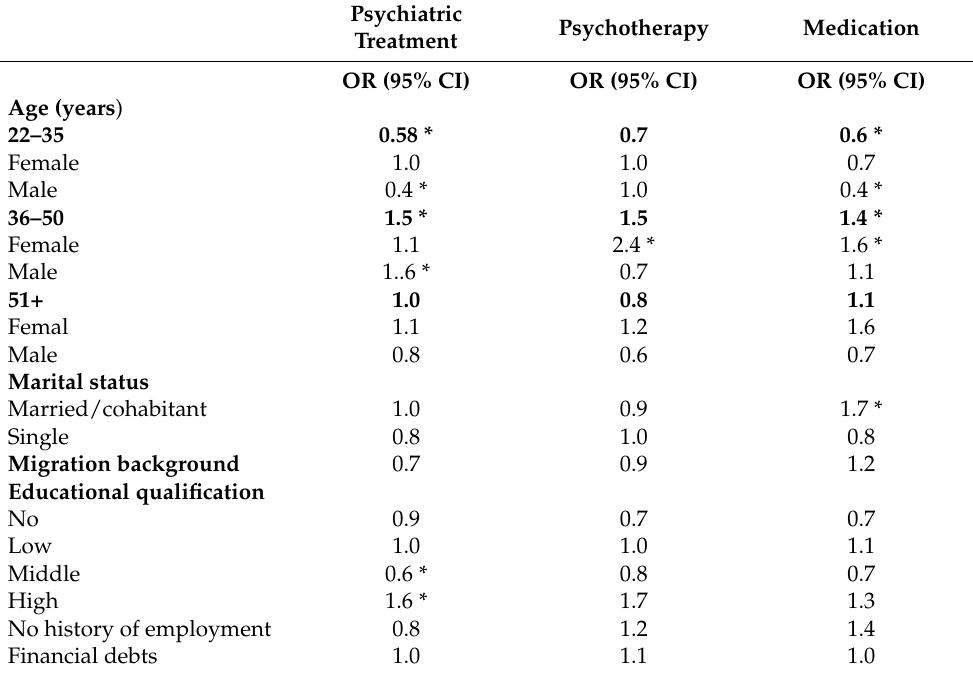
Table 5. Probability of current mental health care